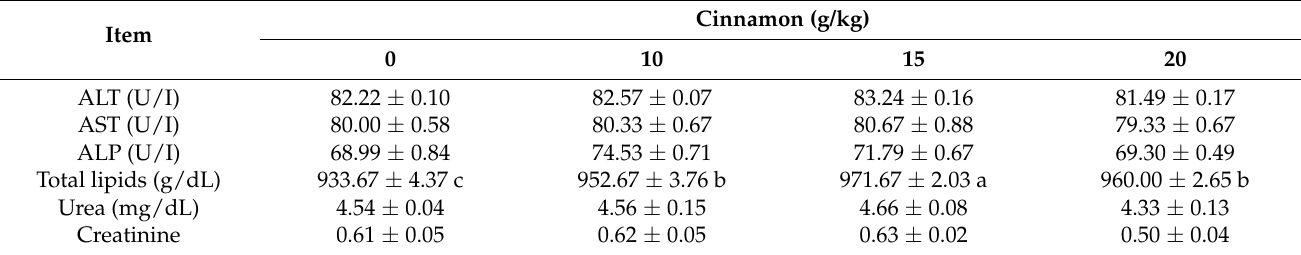
Table 5. Blood biochemical indices of European sea bass fed dietary cinnamon.